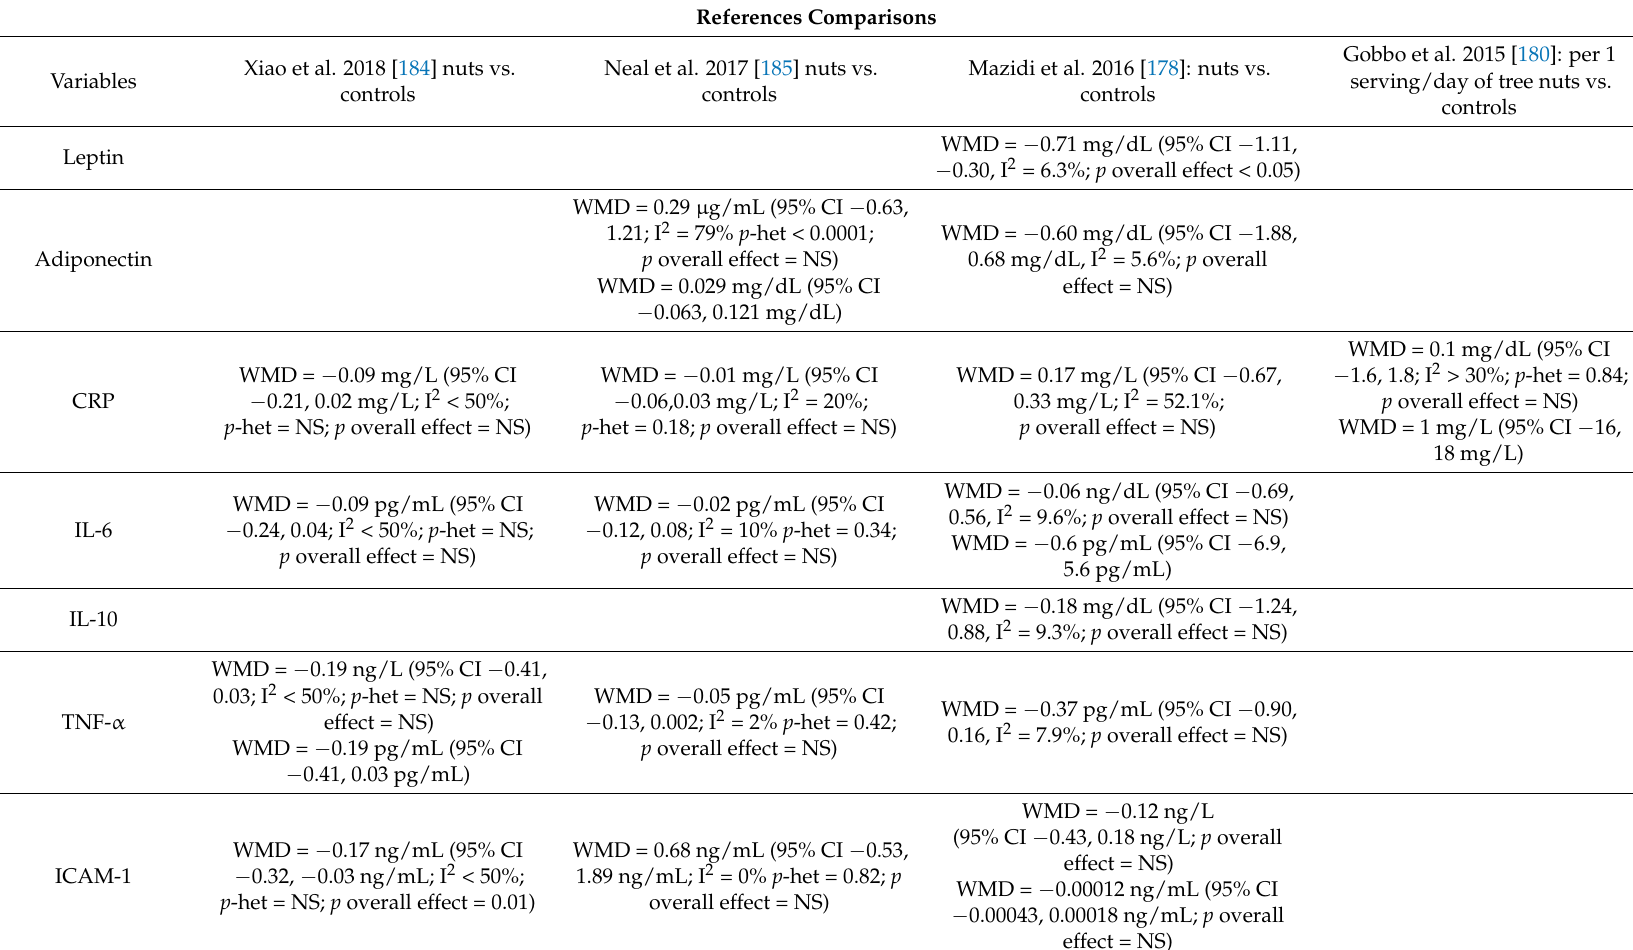
Table 5. Summary of nut consumption and adipokines and inflammatory markers in intervention